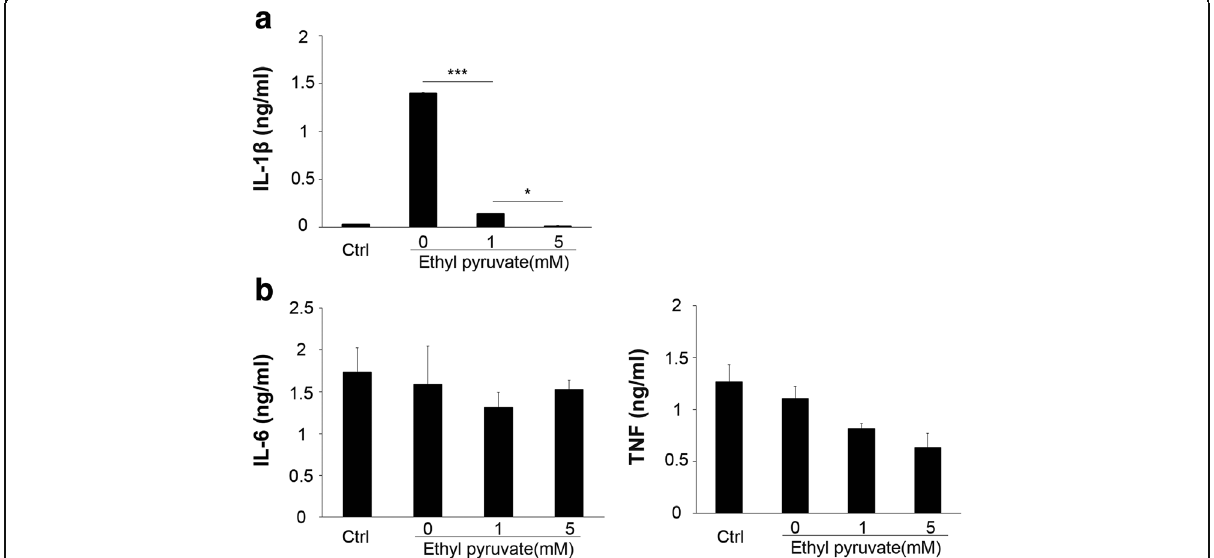
Fig. 7 Ethyl pyruvate inhibits NLRP3 agonists-induced inflammasome activation in human macrophages. Human macrophages were primed with ultra-pure LPS (1 μ g/ml) for 3 h. in the presence or the absence of EP (1 or 5 mM), and then stimulated with ATP (5 mM) for 30 min. a IL-1 β level and ( b ) IL-6, TNF production were determined by ELISA. Results are means ± SEM (n = 3). * p < 0.05; ** p < 0.01; *** p <